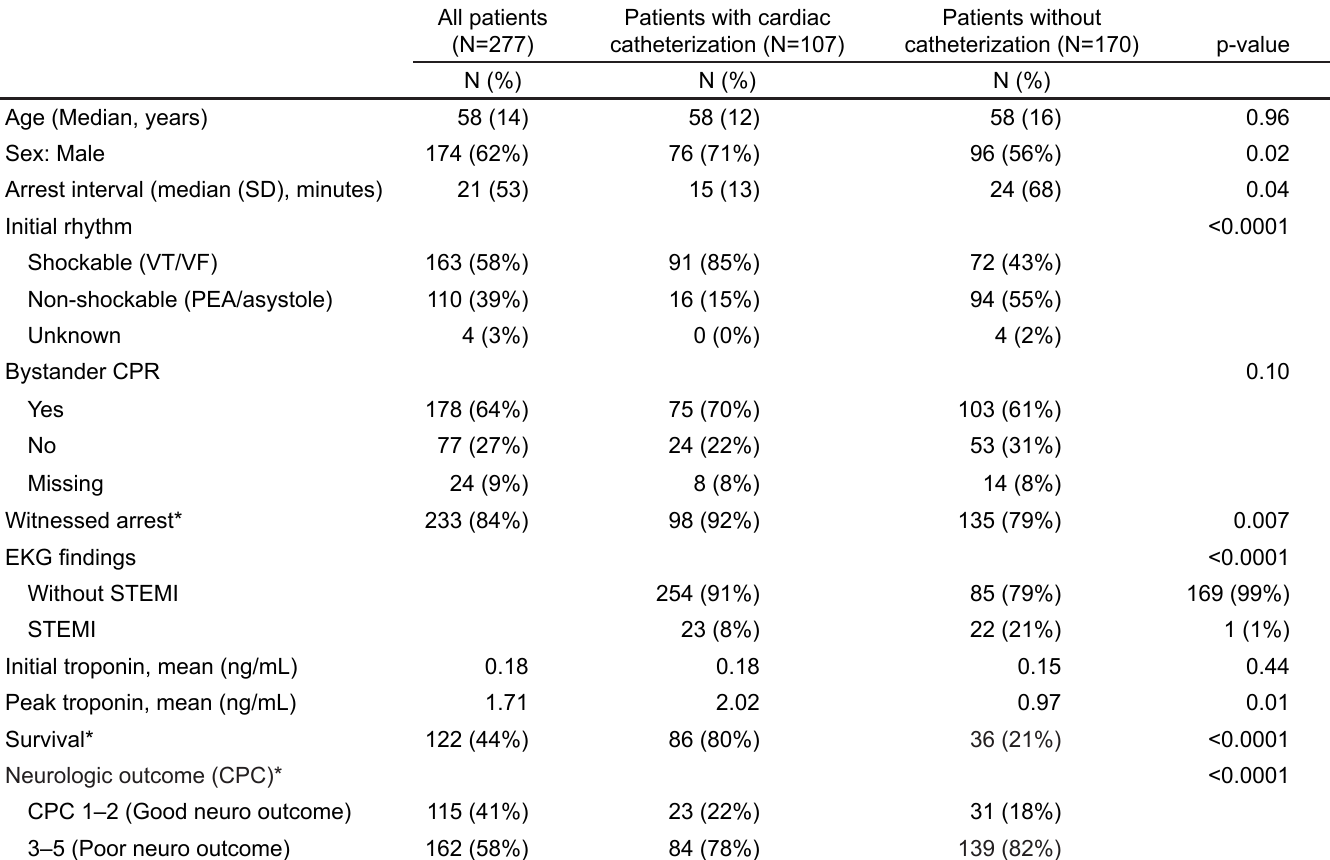
Table 1. Demographic, arrest characteristics, initial ECG, and troponins, and outcomes for overall cohort and in patients with and without cardiac catheterization.